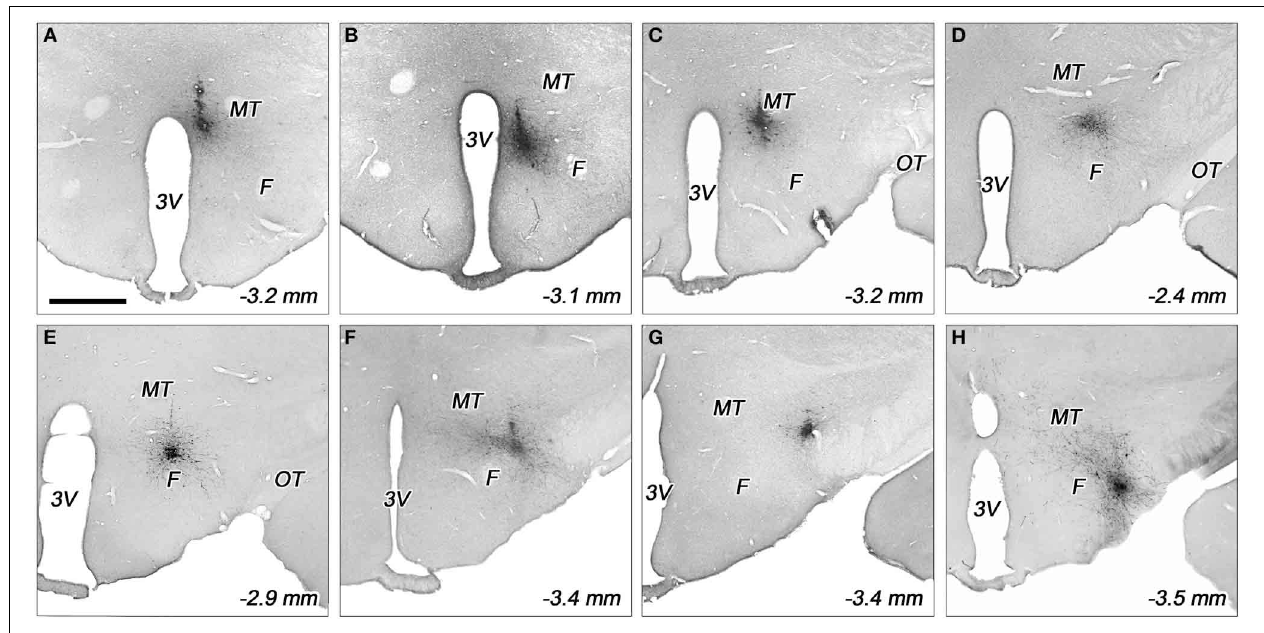
FIGURE 3 | Representative biotinylated dextran amine (BDA) injection sites in various subdivisions of the dorsolateral hypothalamus. The injection sites located in the periventricular area (A) , dorsomedial nucleus (B) , dorsomedial hypothalamus (C) , rostral perifornical area (D) , caudomedial